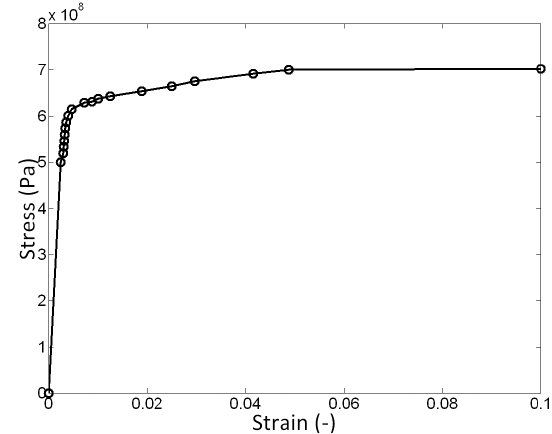
Fig. 8. Stress-Strain relation describing the work-hardening into the